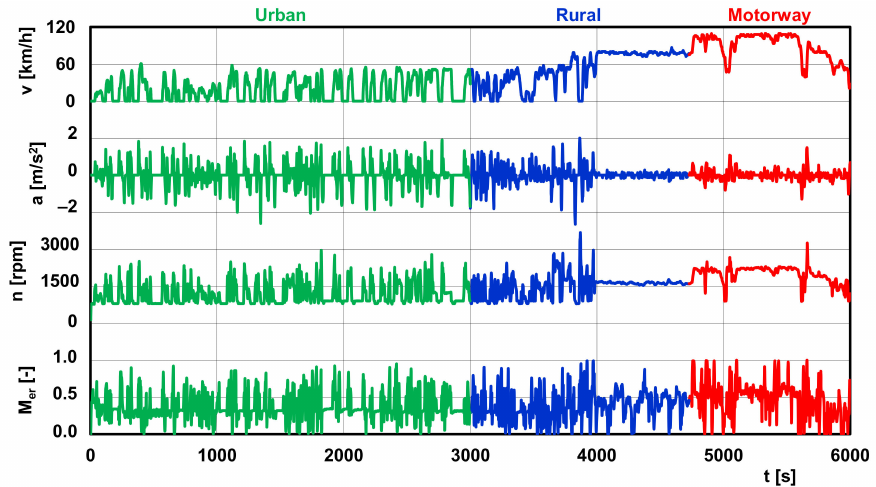
Figure 4. Vehicle velocity, vehicle acceleration, engine speed and relative engine torque as a function of time in the RDE test.